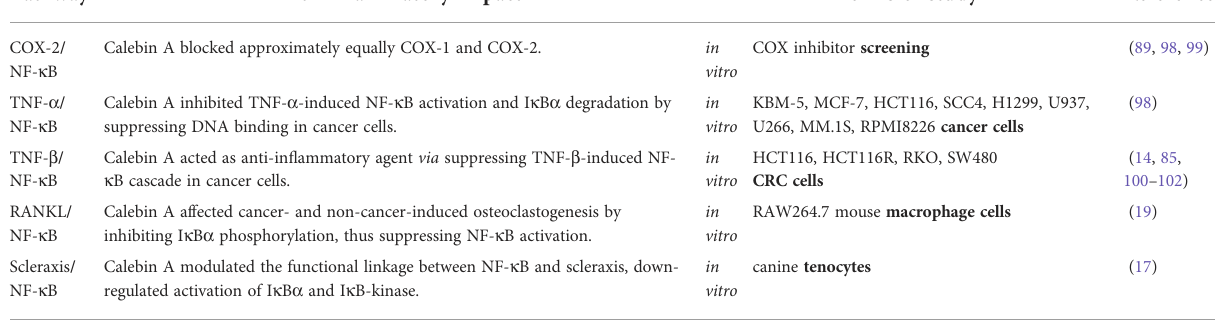
TABLE 1 Calebin A exhibits anti-in fl ammatory activities. Pathway Anti-in fl ammatory impact Terms of